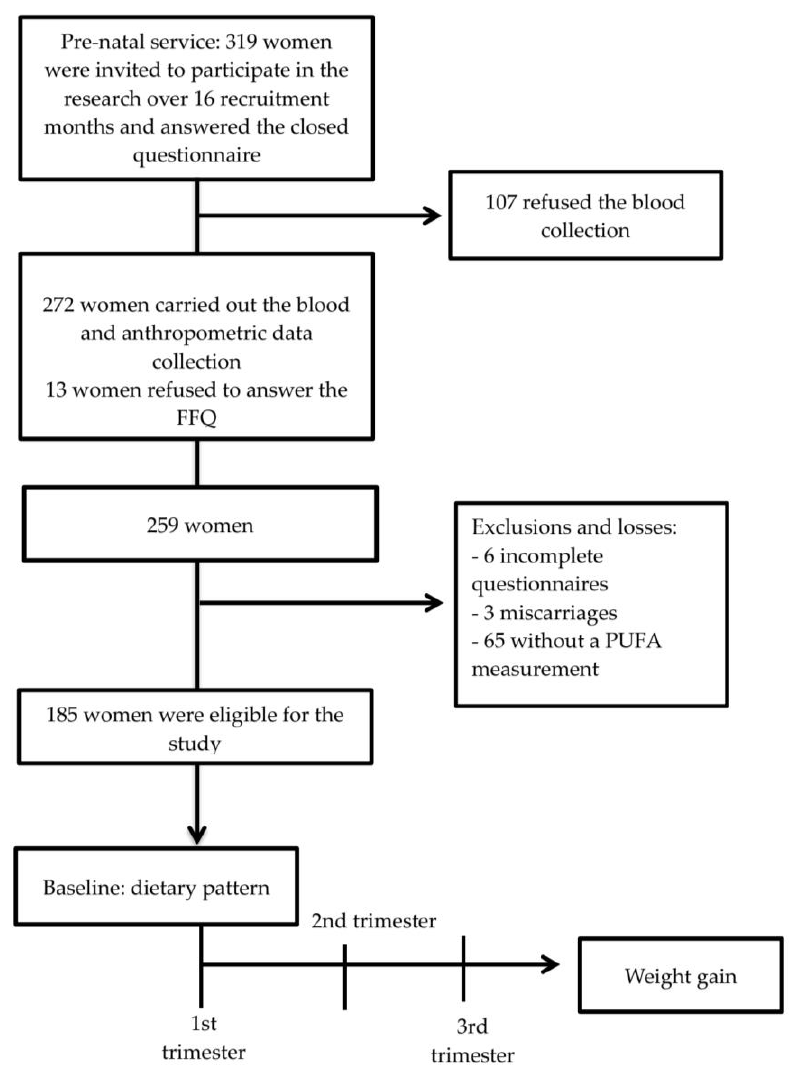
Figure 1. Flowchart of cohort of 185 pregnant women treated in the prenatal service at primary healthcare units in Santo Antônio de Jesus, Bahia, Brazil, 2017.